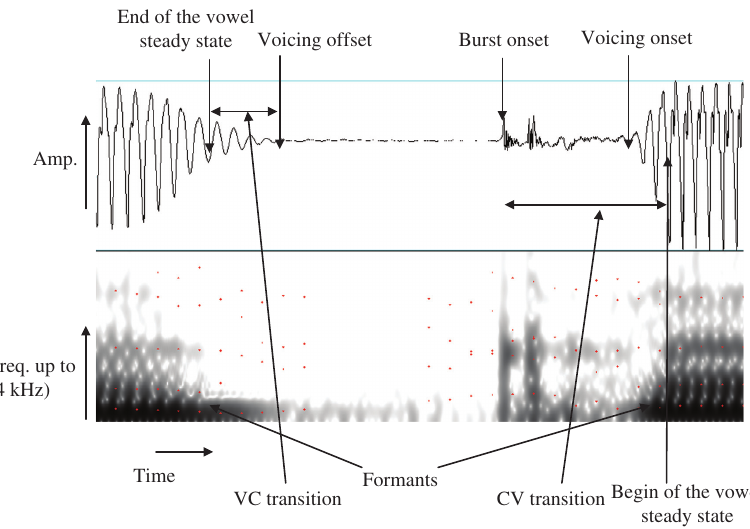
Figure 1. Waveform, Spectrogram, Formants (Shown with Dots), and Important Points in Transitions to and from the Stop in the VCV Syllable / a k a